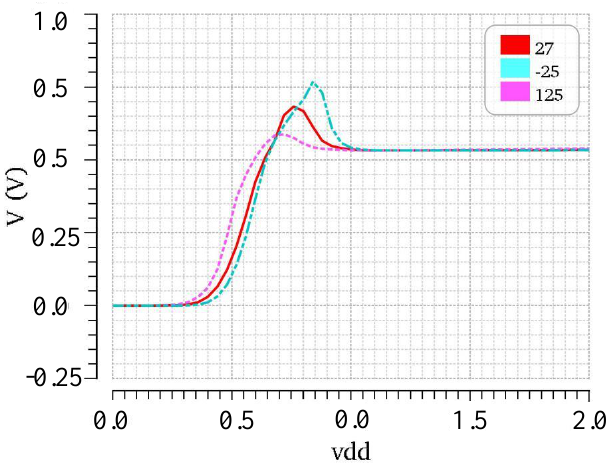
Figure 10. Reference voltage on the supply voltage in different operating temperatures (reference 2). The simulation results of the bandgap reference voltage of −25 to 125 °C for various supply voltages are shown in Figure 11. The temperature coefficients at 1, 1.2, 1.4, 1.6, 1.8, and 2 V supply voltage are less than 10 × 10 − 6 /°C. In particular, the accuracy of BGR is the highest at 1.2 V voltage. Figure 11. Reference voltage on the operating temperature in different supply voltage (reference 2). Figure 12 shows that the reference circuit can start up normally in 3 us after the sup- ply is turned on.